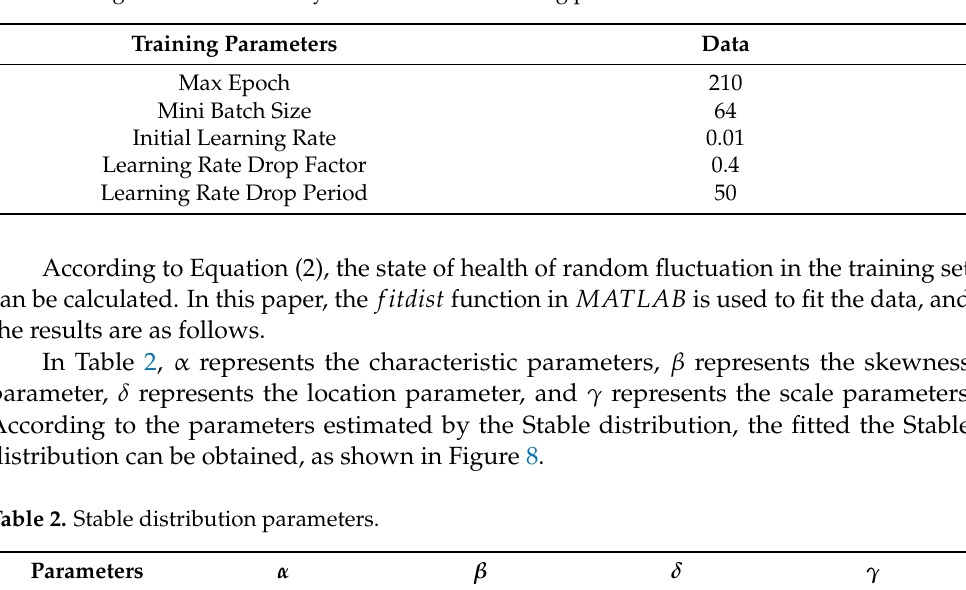
Table 1. Long short-term memory neural network training parameters.